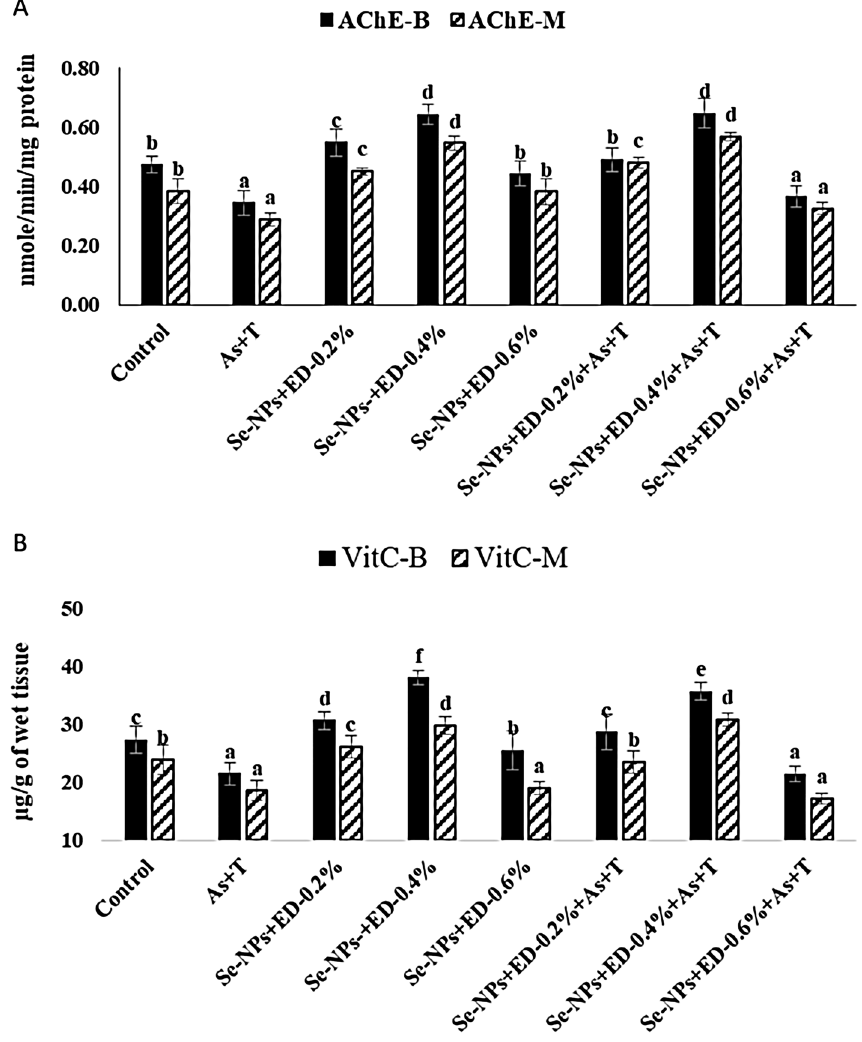
Figure 3. ( A , B ) Mitigation of secondary stress response (acetylcholine esterase and vitamin C) through dietary selenium nanoparticles, eicosapentanoic acid and dicosahexanoic acid fed to P. hypophthalmus reared in control or under arsenic and high temperature (As + T) for 105 days. Within endpoints and groups, bars with different superscripts differ significantly (a–f) AChE-B (p = 0.0028), AChE-M (p = 0.029), VitC-B (p = 0.0056), VitC-M-G (p = 0.038). Data expressed as Mean ± SE (n = 6).